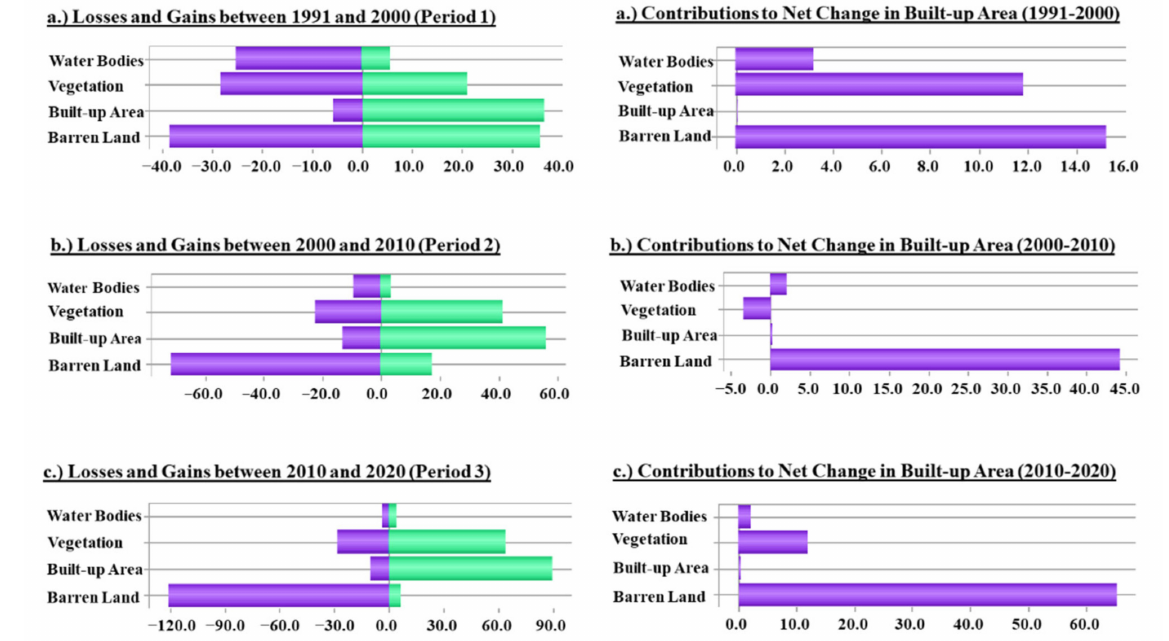
Figure 5. Net changes of the various LULC classes and their contributions to built-up areas (in sq.km) during the different study